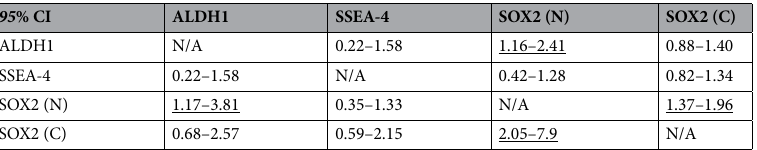
Table 4. Association of different markers in the RC-only cohort. Table shows 95% confidence interval of relative risk for high expression (H-score ≥ 4) of a marker on the column when expression of another marker on a row is high. For example, high expression of ALDH1 is associated with high nuclear expression of SOX2. Confidence intervals not including 1.0 are underlined.